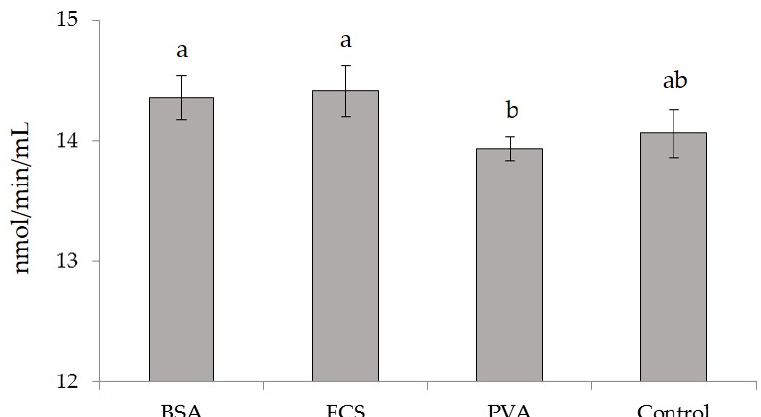
Figure 2. The mean glutathione peroxidase (GPx) enzyme activities (nmol/min/mL) in bovine oocytes matured in media supplemented with different macromolecules. BSA = bovine serum albumin, FCS = fetal calf serum, PVA = polyvinyl alcohol. The error bars represent the standard error of means, and bars with different letters are significantly different at p < 0.05.